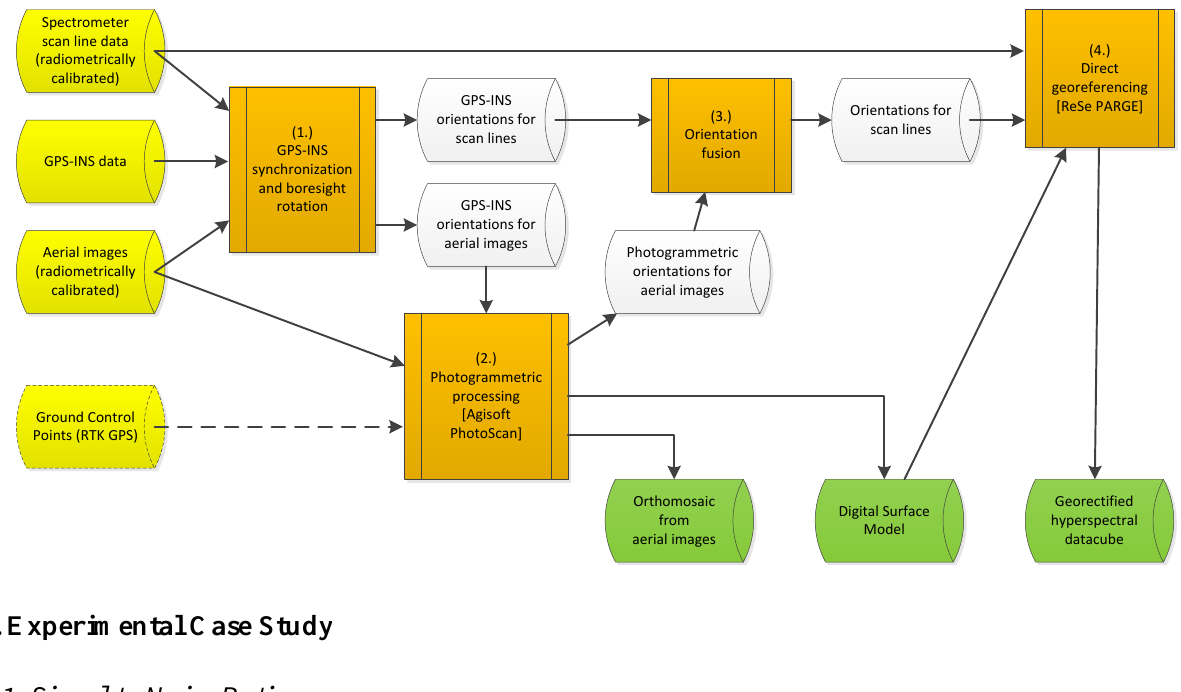
Figure 3. Flowchart of the HYMSY geometric processing chain. The radiometric (reflectance factor) processing (Section 3.1) is done prior to geometric processing. The yellow cylinders are input data, white cylinders are temporary data, and green cylinders are final output data products. Orange boxes are processing